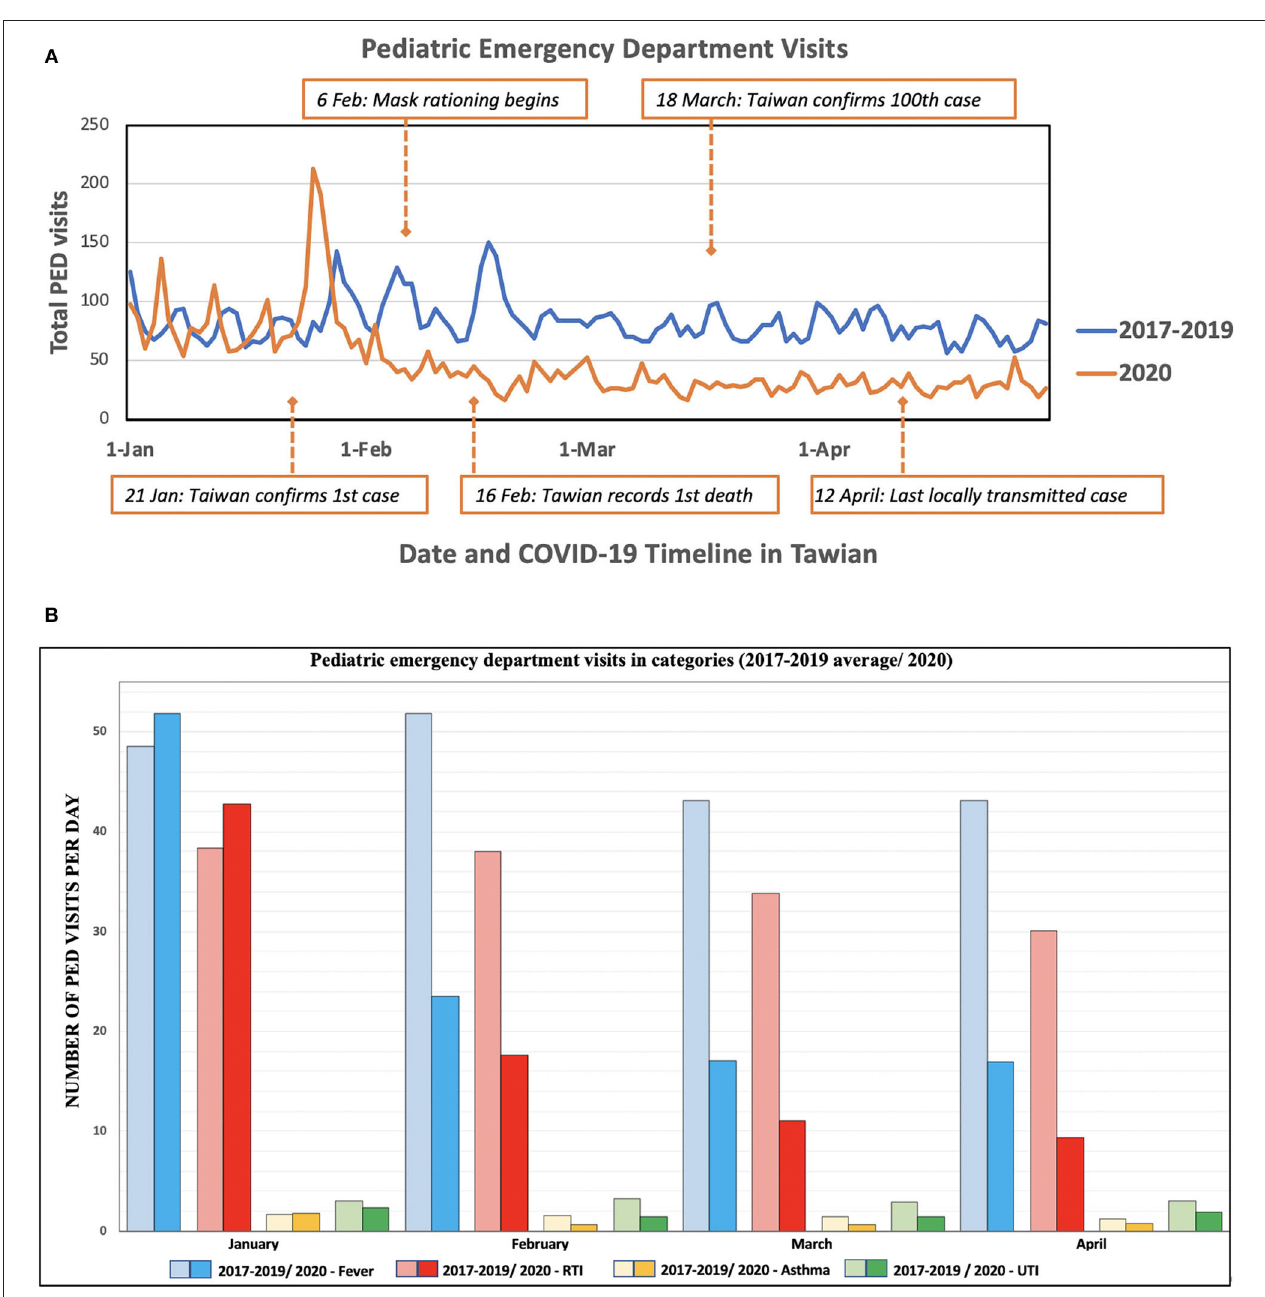
FIGURE 2 | Comparison of average visits from 2017 to 2019 and for 2020 at Kaohsiung Chang Gung Memorial Hospital. (A) Total visits at pediatric emergency department. (B) Pediatric emergency department visits in categories. PED, pediatric emergency department; RTI, respiratory tract infection; UTI, Urinary tract